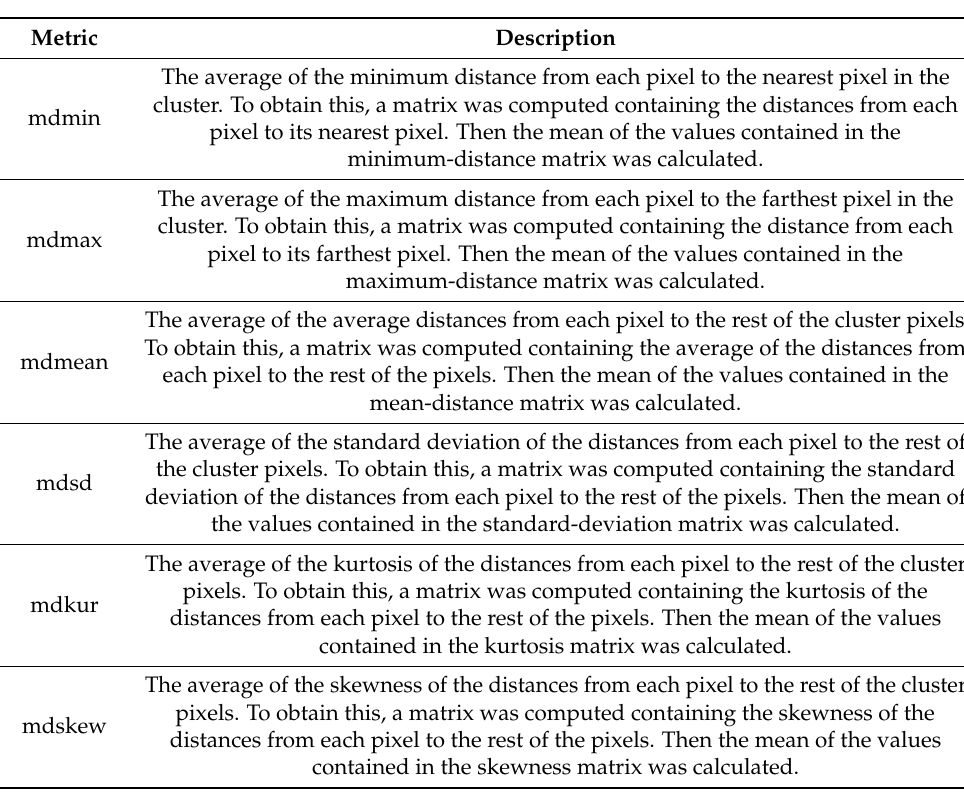
Table 1. Set of metrics calculated for each detected disturbance cluster to study how the pixels of the cluster are distributed in relation to one another.